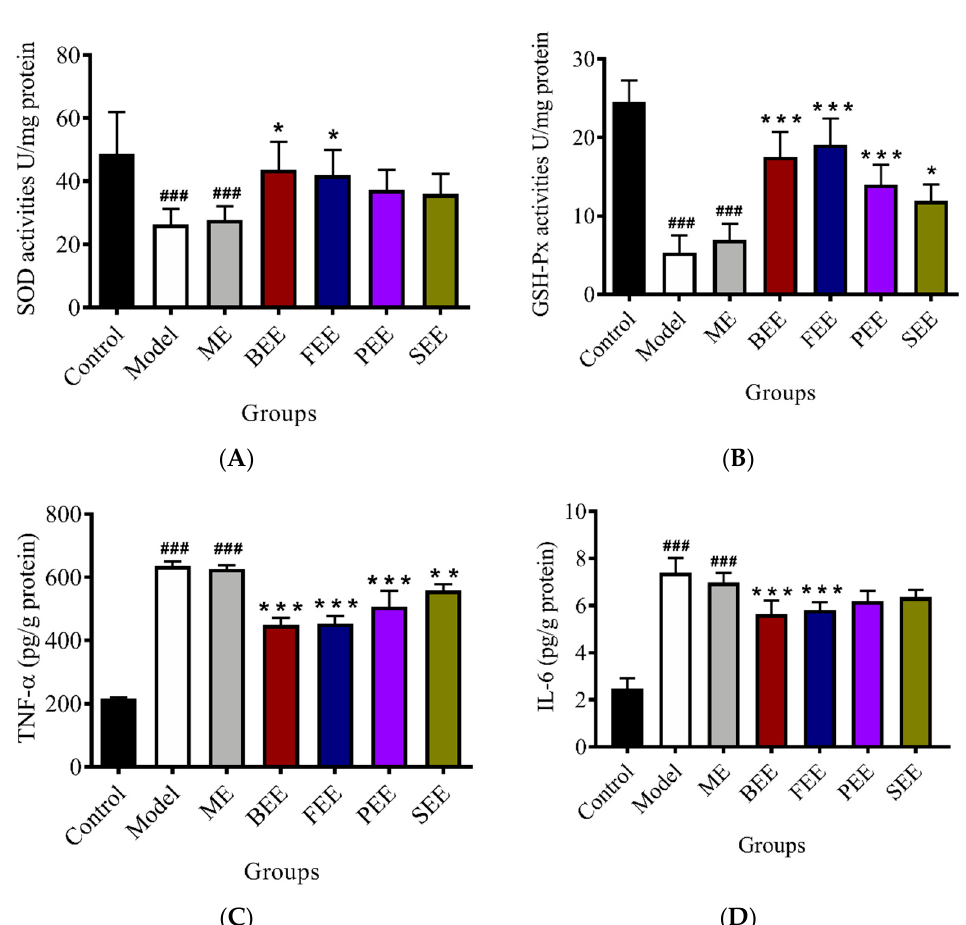
Figure 4. Effects of ethanolic extracts of Paeonia suffruticosa flowers on the activities of antioxidant enzymes and the concentrations of pro-inflammatory cytokines in UVB-irradiated mouse skin. Concentrations of SOD ( A ), GSH-Px ( B ), TNF- α ( C ), and IL-6 ( D ) in dorsal skin tissues were determined using mouse-specific enzyme-linked immunosorbent assay (ELISA) kits. Control group: no irradiation; Model group: irradiated group with no treatment; Model + emulsifier (ME) group: irradiated group treated with emulsifier; Bud ethanolic extract (BEE) group: irradiated group treated with 2.0% ( w / w ) BEE in emulsifier; Flower ethanolic extract (FEE) group: irradiated group treated with 2.0% ( w / w ) FEE in emulsifier; Petal ethanolic extract (PEE) group: irradiated group treated with 2.0% ( w / w ) PEE in emulsifier; Stamen ethanolic extract (SEE) group: irradiated group treated with 2.0% ( w / w ) SEE in emulsifier. Data were expressed as mean ± SD ( n = 6). * p < 0.05, ** p < 0.01, and *** p < 0.001 versus ME group; ### p < 0.001 versus control